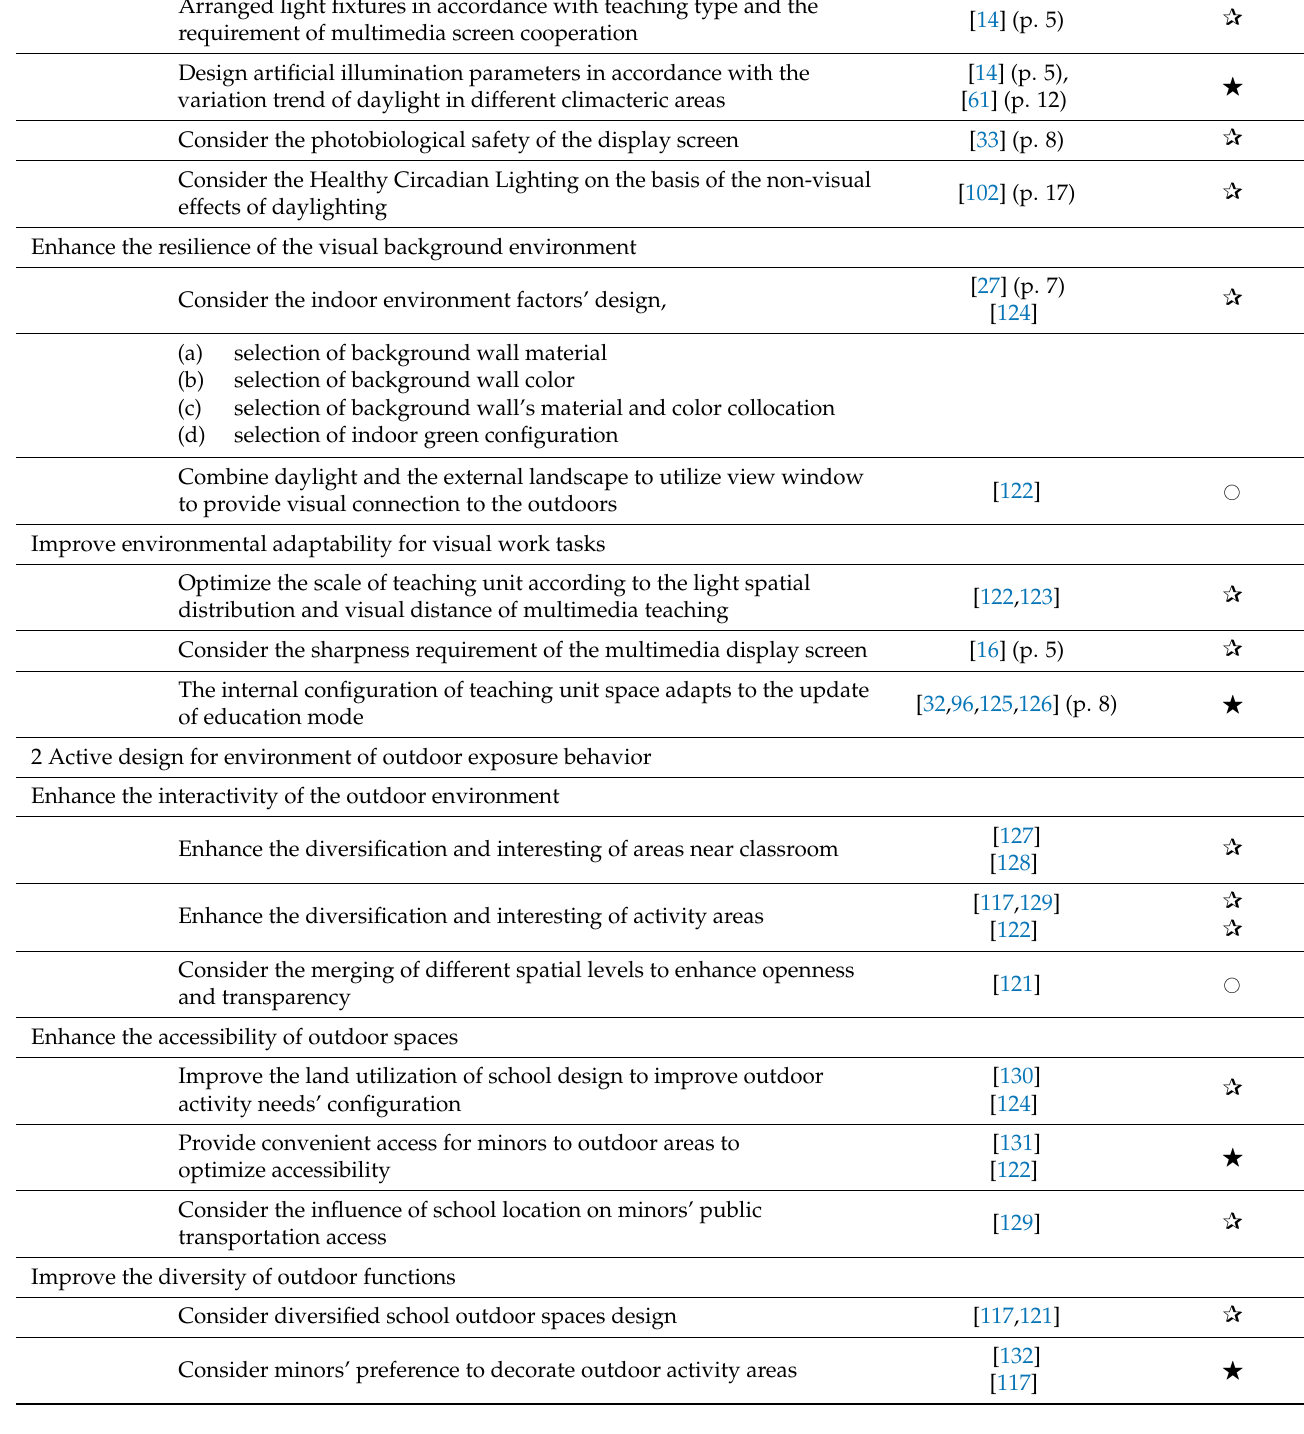
Table 3. Visual health design guidelines for school architecture.